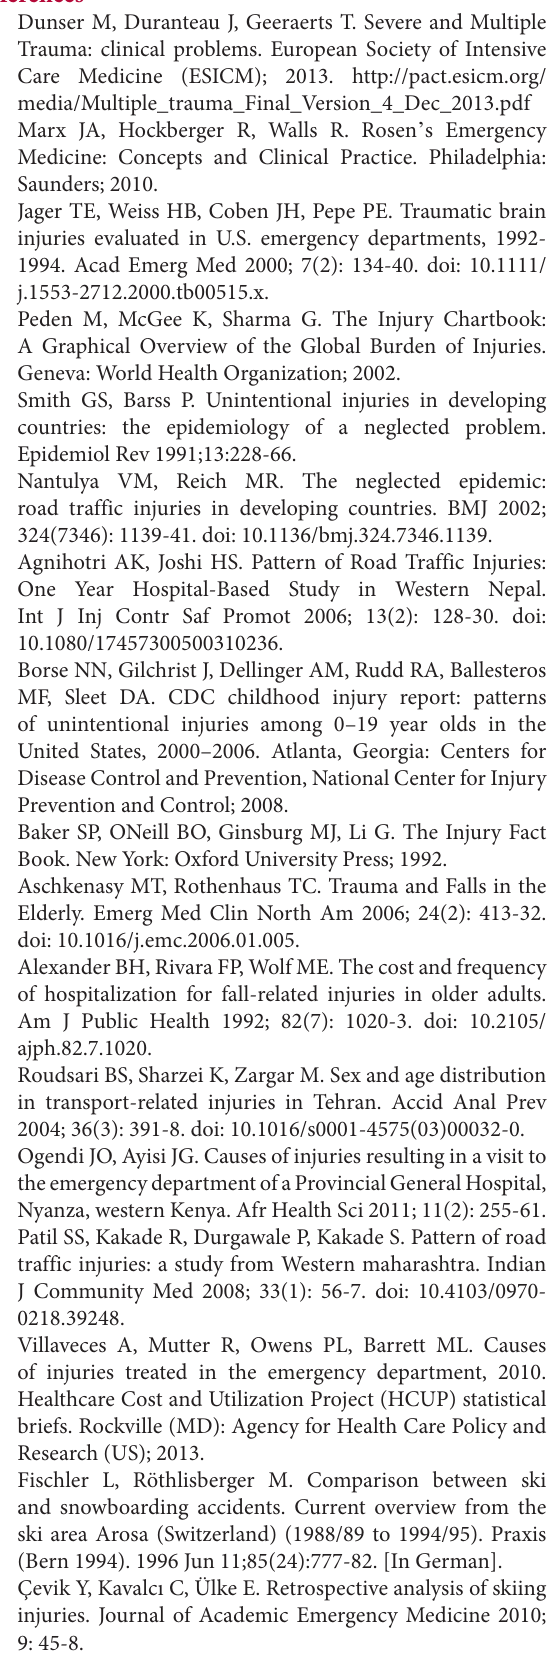
Table 1. Prevalence of type of trauma Type of trauma No. of